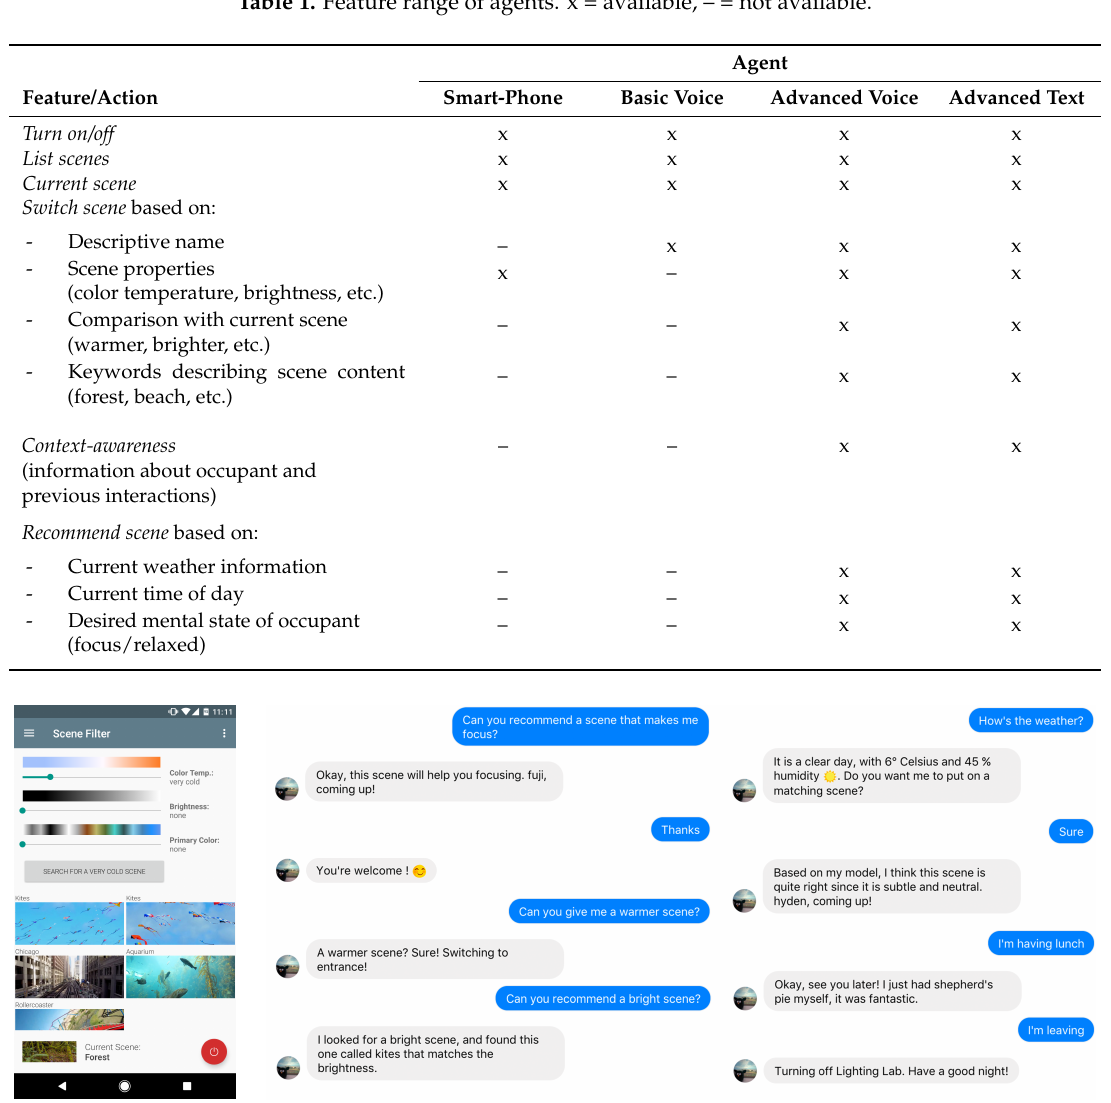
Figure 4. Examples of user interface for interaction with Mediated Atmospheres . Left : Graphical User Interface of Smartphone Application ; Right : Example dialog between user and Advanced Text Agent